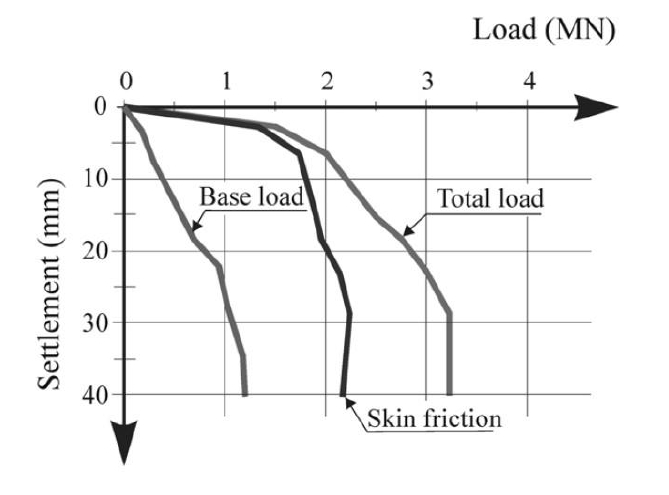
Fig. 11. Load- settlement curves for pile loading test [15]. Table 3.represents the material properties and constitutive model used in 3D-finite element models. Features of the behavioral model and materials in the pile's 3d loading